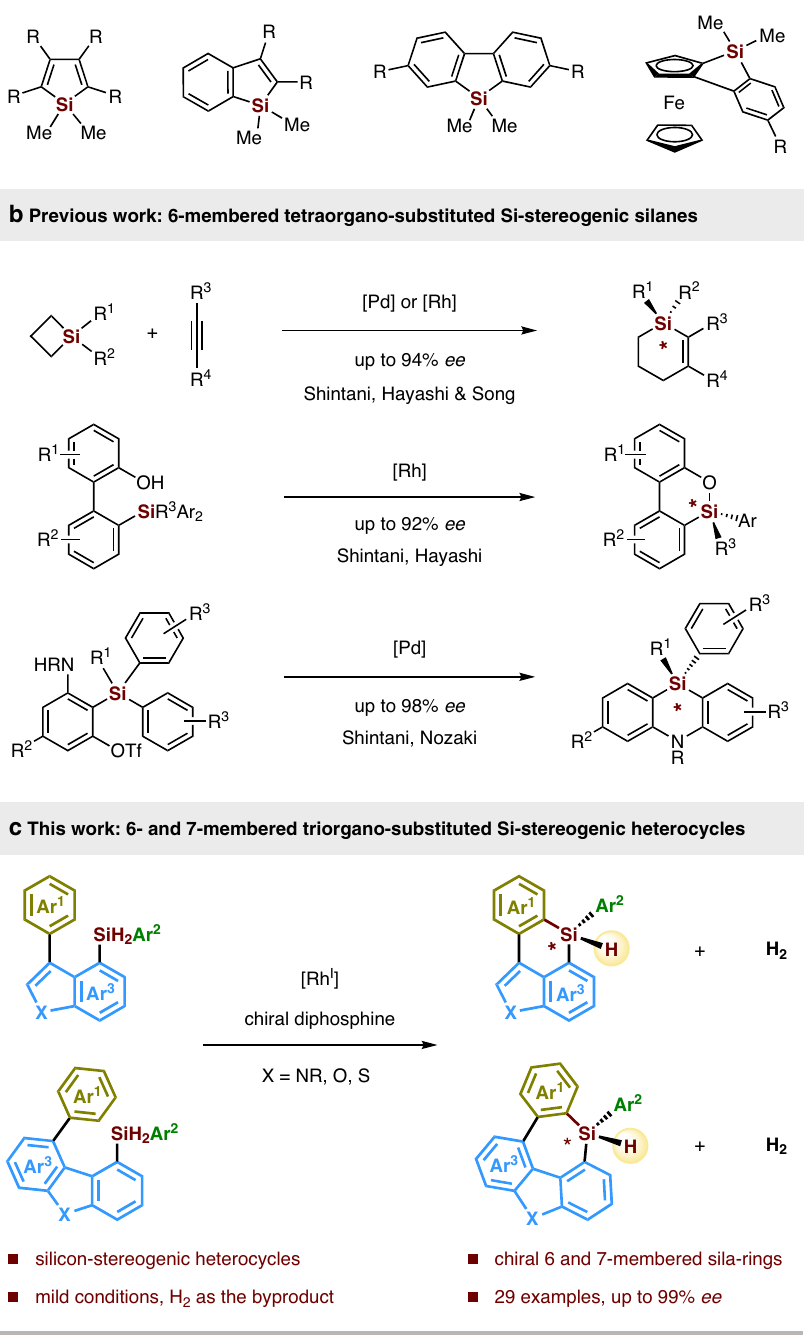
Fig. 1 Construction of silicon-containing π -conjugated molecules. a Representative silicon-containing π -conjugated molecules. b Asymmetric synthesis of six-membered tetraorgano-substituted Si-stereogenic silanes (previous work). c Enantioselective construction of six- and seven-membered triorgano- substituted Si-stereogenic heterocycles (this